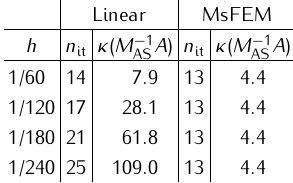
Table 4. Iteration numbers n and condition numbers κ ( M − 1 A ) for Experiment 2; geometry: 1 /h× 1 /h×H/h ; H = 12 h ; linear and multiscale it AS coarsening for different h ; contrast: E c = 10 6